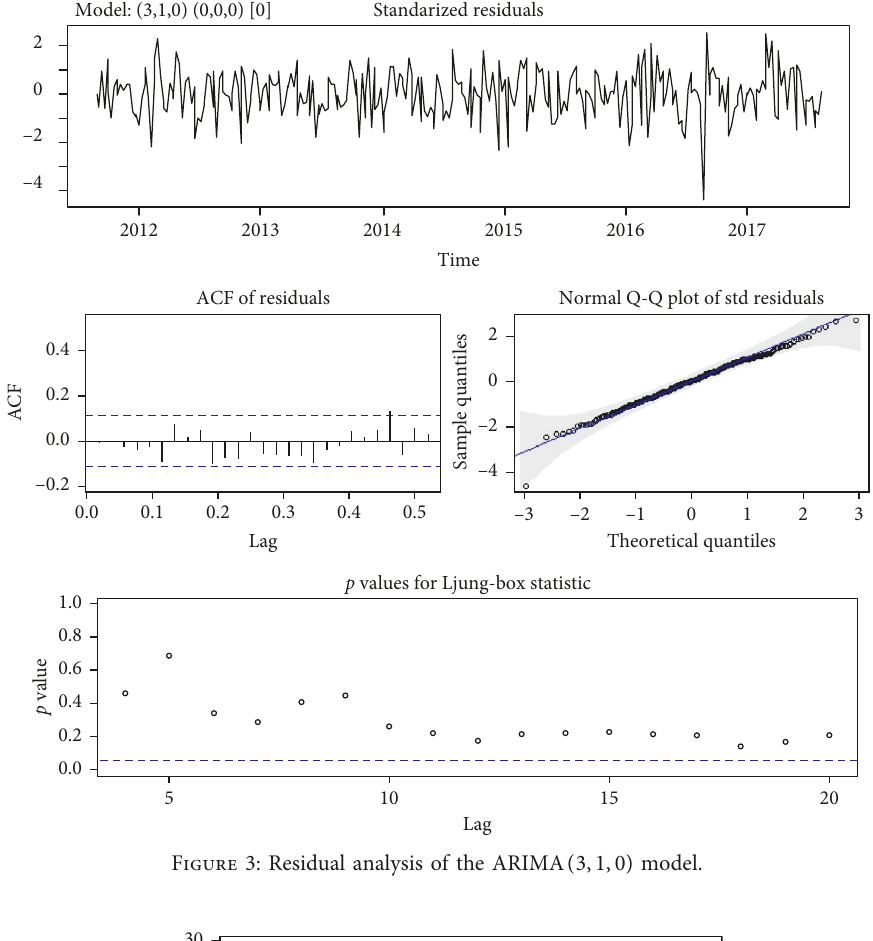
Figure 3: Residual analysis of the ARIMA